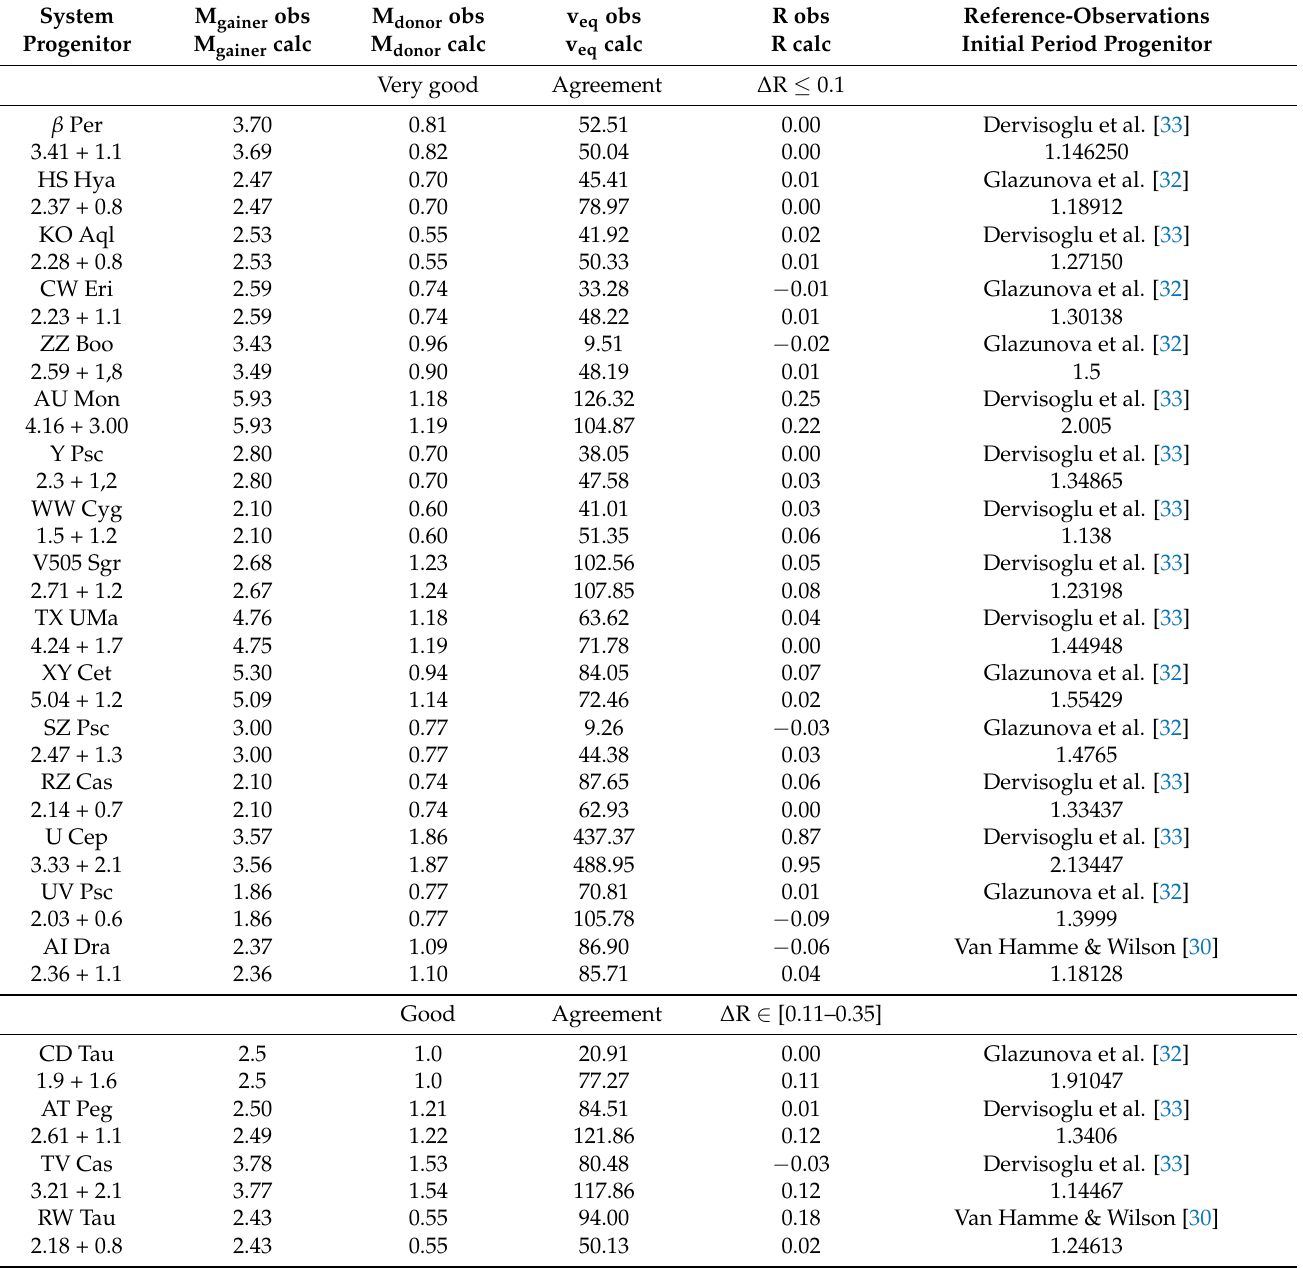
Table 1. Calculated equatorial velocities of gainers that best fit observations. Masses are in M (cid:12) , orbital periods in days and v eq in km . For each system, two lines are given, the first with data from observations and the second with the results from sec the model. The masses mentioned by the observations of Glazunova et al. [32] are from Budding et al.